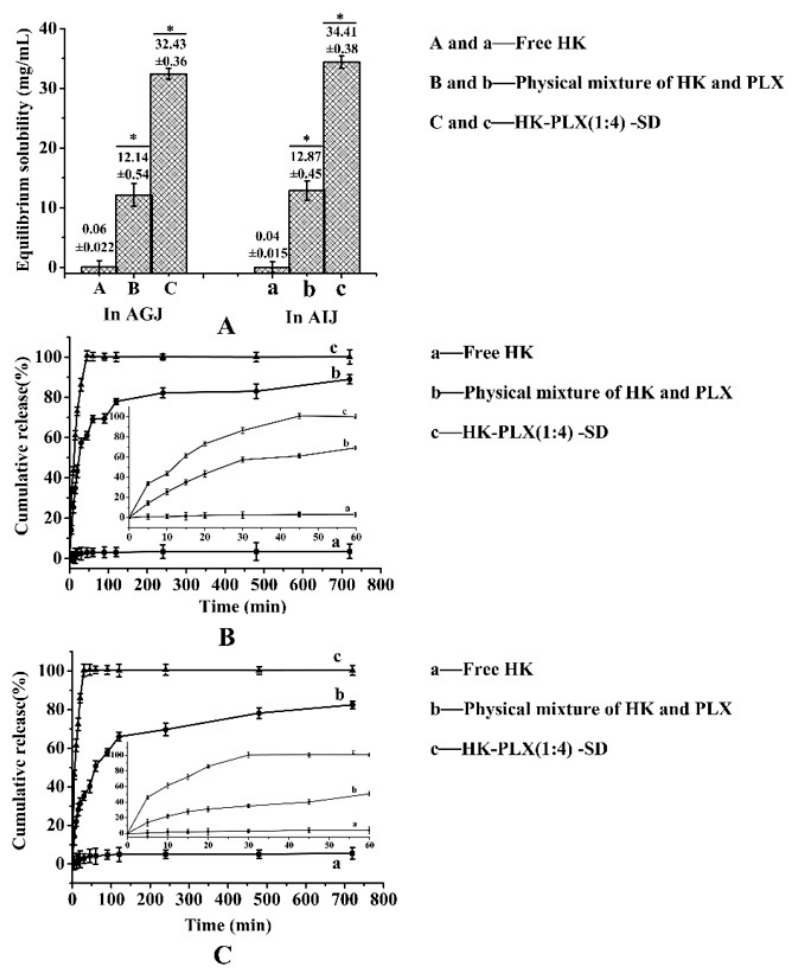
Figure 8. Equilibrium solubility (* p < 0.05) ( A ) and the release profiles in artificial gastric juice ( B ) and artificial intestinal juice ( C ) for free HK, the physical mixture, and the HK–PLX (1:4)